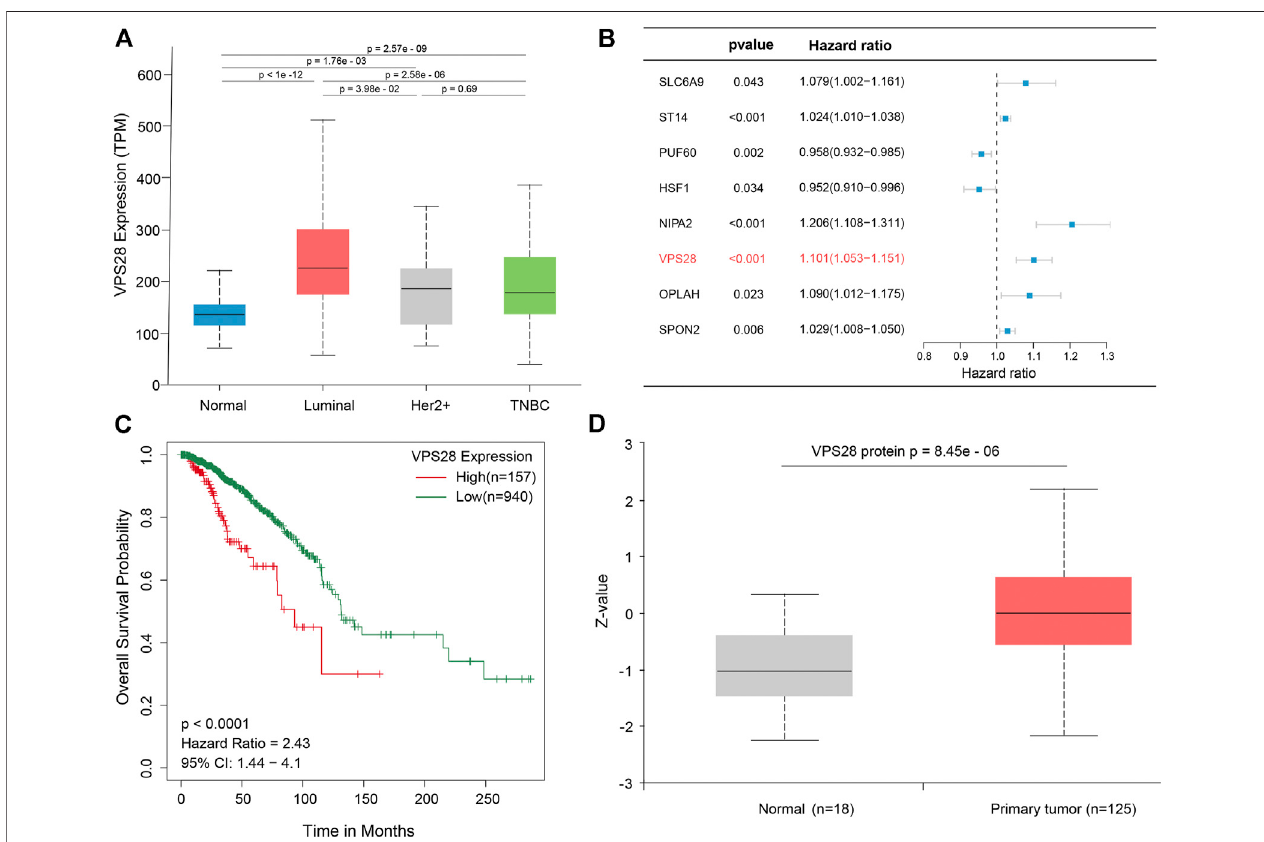
FIGURE 2 | VPS28 expression in different subtypes of breast cancer, according to the TCGA database (A) . Batch multi-Cox regression analysis for OS showed thateightgenesrepresentedindependentriskfactorsforbreastcancer,including SLC6A9 , ST14 , PUF60 , HSF1 , NIPA2 , VPS28 , OPLAH ,and SPON2 (B) .K-Manalysis shows that high expression VPS28 was associated with a poor prognosis of breast cancer patients (C) . VPS28 protein expression levels in breast cancer tissues and normal mammary tissues according to the CPTAC database (D) .